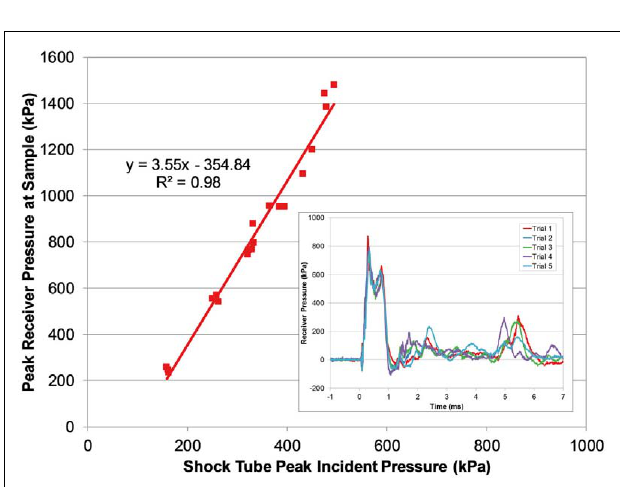
FIGURE 9 | Comparing peak pressure measured in the receiver with the peak incident pressure of the applied blast wave. The transient pressure pulse in the receiver was very reproducible (inset; 3800